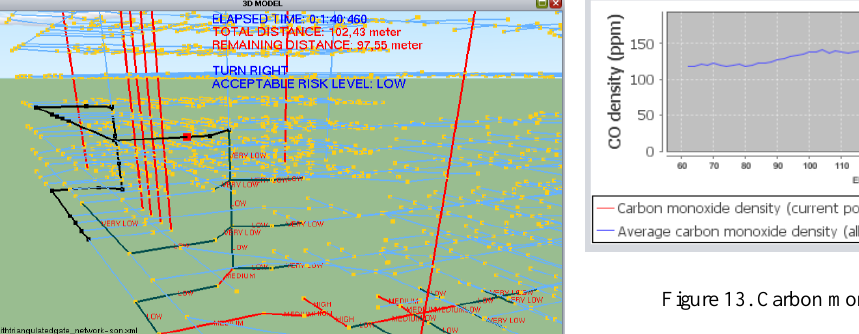
Figure 10. Evacuation scenario (Scene-3).